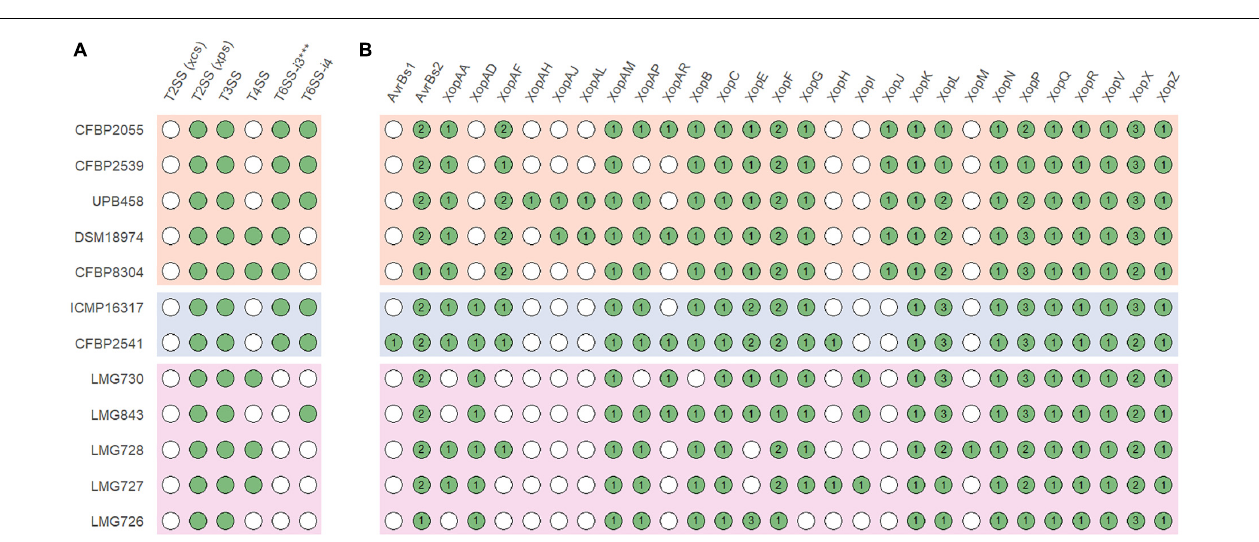
bacterial species. These are the first complete genome